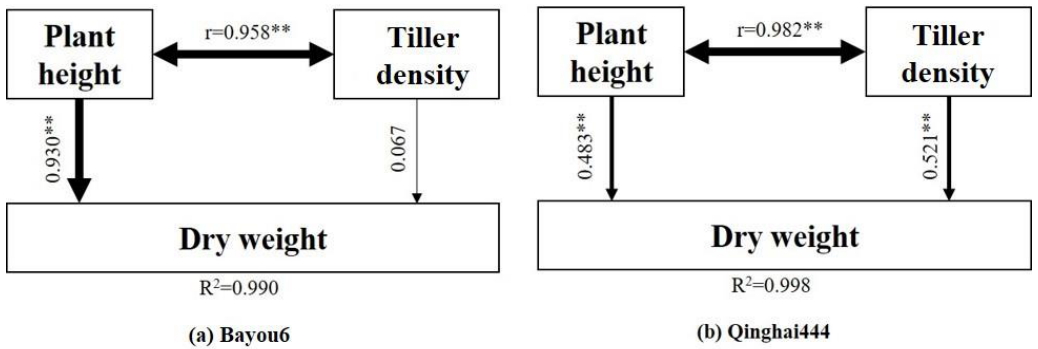
Figure 6. Relationships between re-growth dry weight and plant height ( a ) and tiller density of the two oat species ( b ).